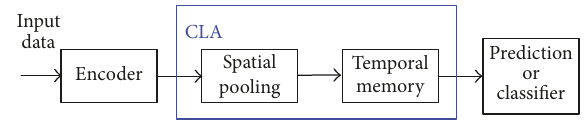
Figure 1: Workflow of an HTM application.